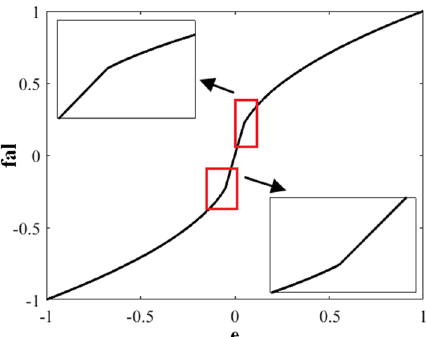
Fig. 6 The fal function for α